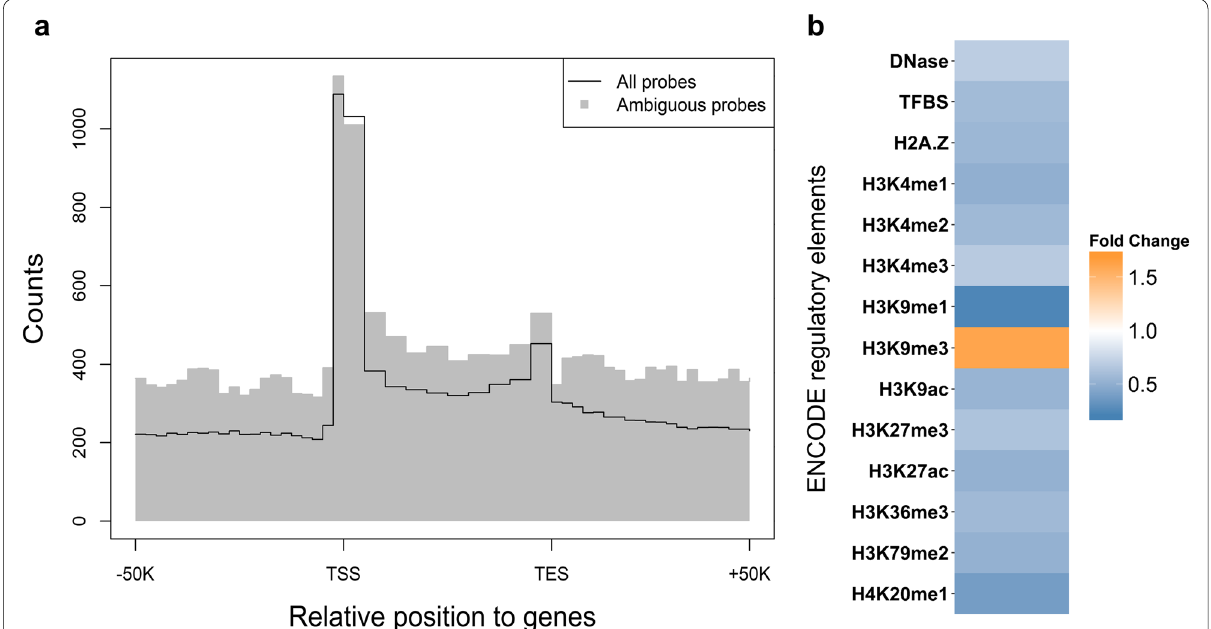
Fig. 2 Summary of the EPIC probes with Illumina annotations. a Ambiguous probes generally follow the distribution of all EPIC probes in terms of relative position to the gene. The black line represents all EPIC probes. The grey bar represents ambiguous probes. b Enrichment analysis indicates that ambiguous probes are more likely to co-localize with H3K9me3. DNase, DNase I hypersensitivity sites; TFBS, transcription factor binding sites; H2A.Z, histone H2A variant; H3, histone H3; H4, histone H4; K, lysine; me1, monomethylation; me2, demethylation; me3, trimethylation;